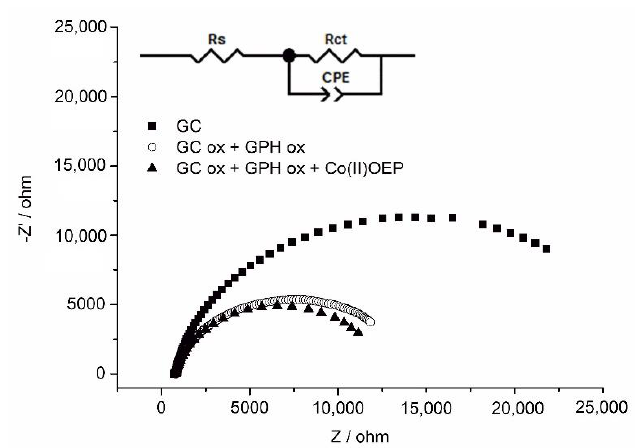
Figure 7. Nyquist plot and equivalent circuit used for GC, GC ox + GPH ox, and GC ox + GPH ox + Co(II)OEP systems, in O 2 -saturated 0.1 M NaOH solution at E = − 0.4 V, frequency range 0.1–100,000 Hz. Table 2. Parameters obtained with the equivalent circuit of Figure 7. E O is the onset potential, Rs is solution resistance, Rct the charge transfer resistance, and CPE the constant phase element.